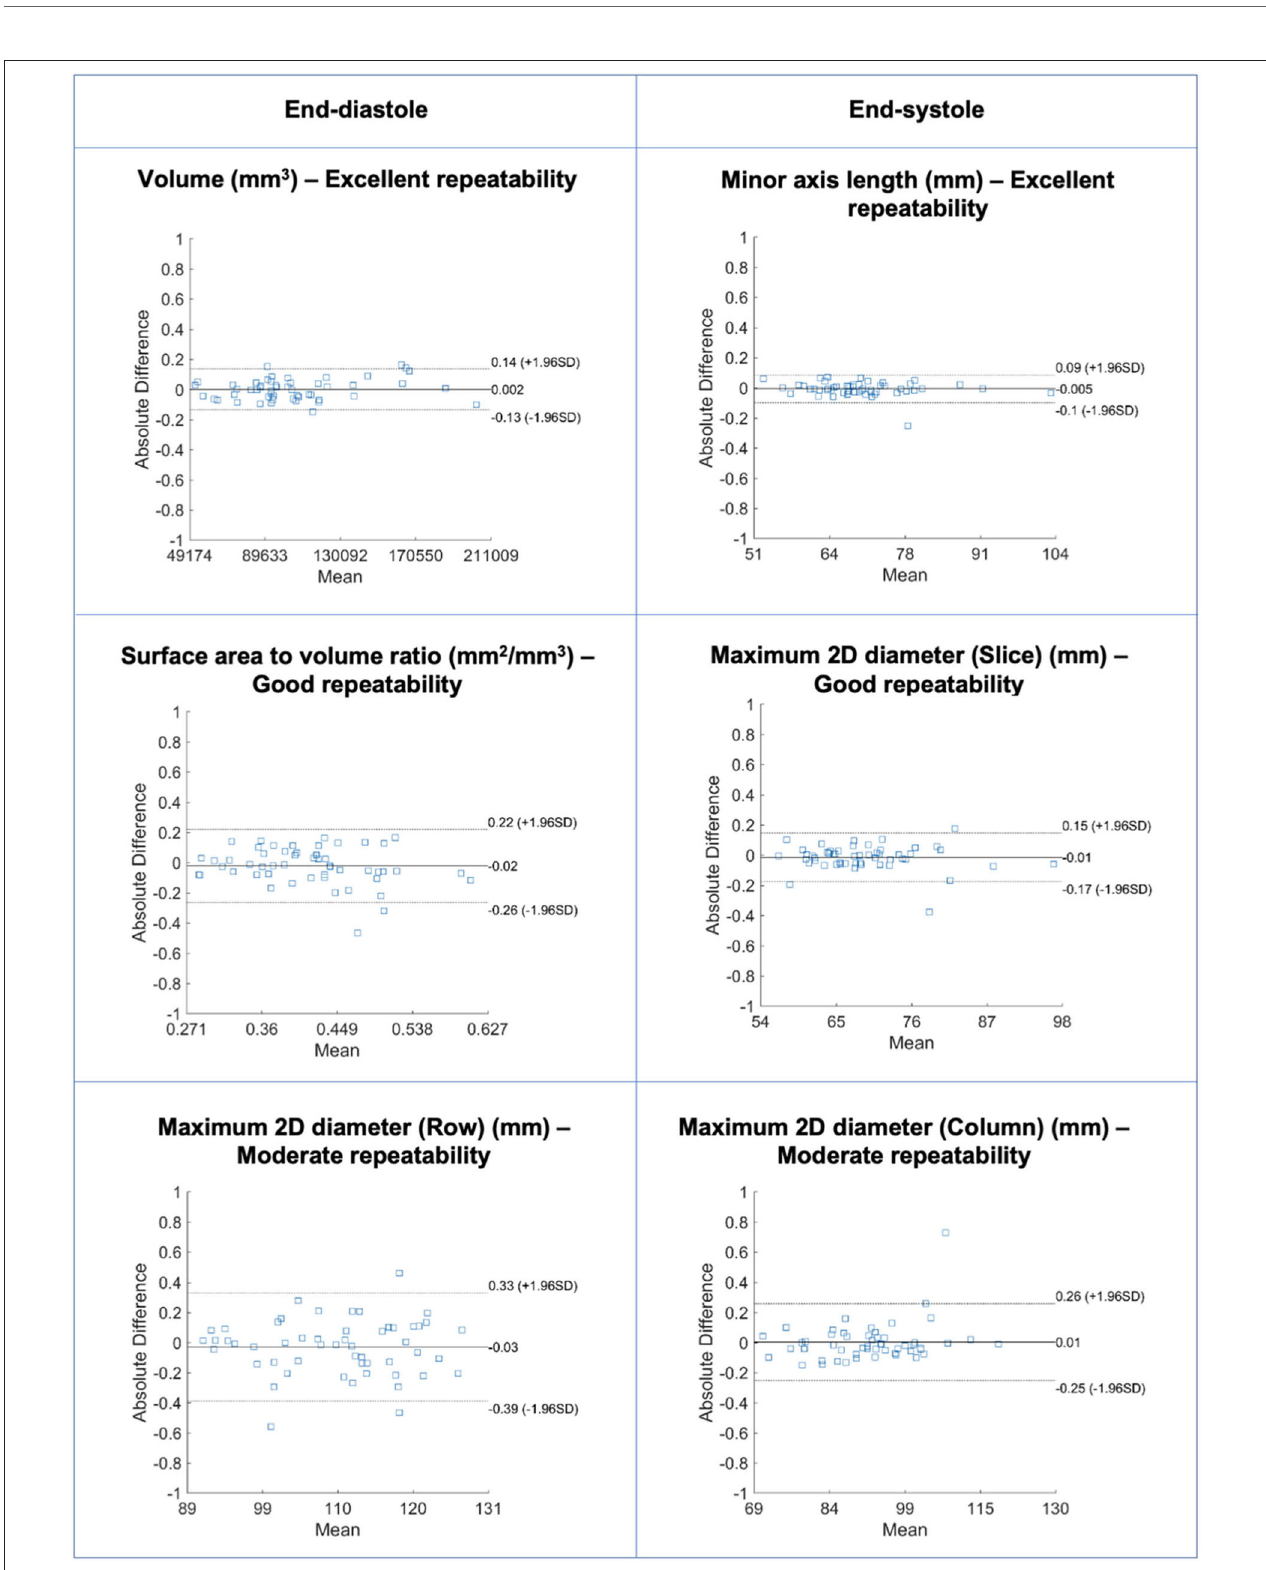
FIGURE 5 | Bland-Altman plots for selected LV myocardium shape features in end-diastole (left) and end-systole (right) with different levels of repeatability. Differences in Bland-Altman are calculated after normalizing radiomics in the range [0–1] to facilitate comparison among different features. All features are unitless. LV: left ventricle.